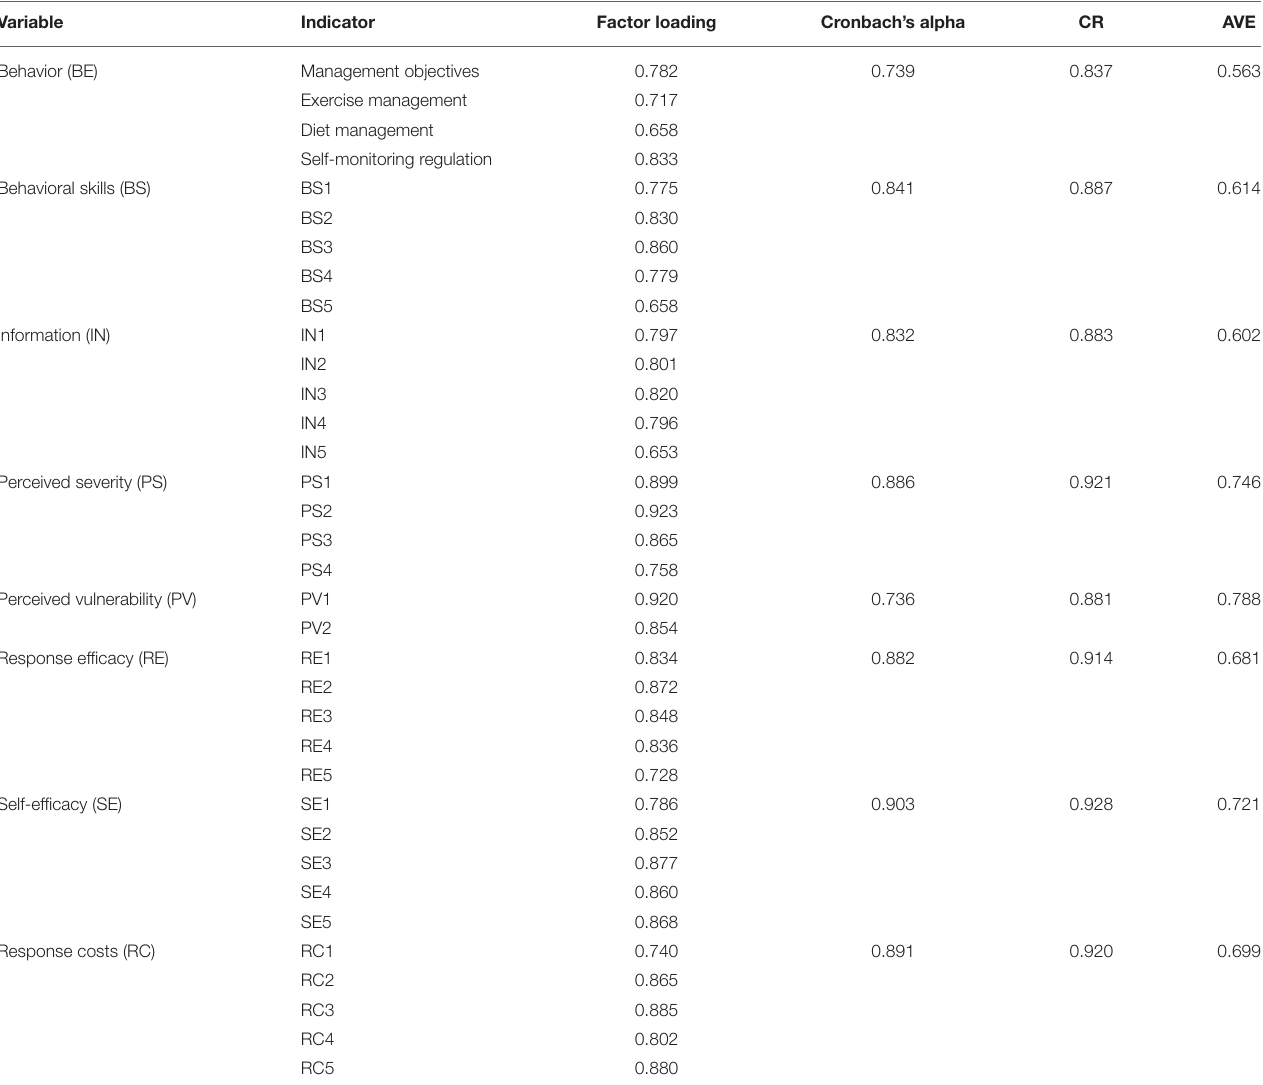
TABLE 3 | Factor loading, internal consistency, and convergent validity of the measurement